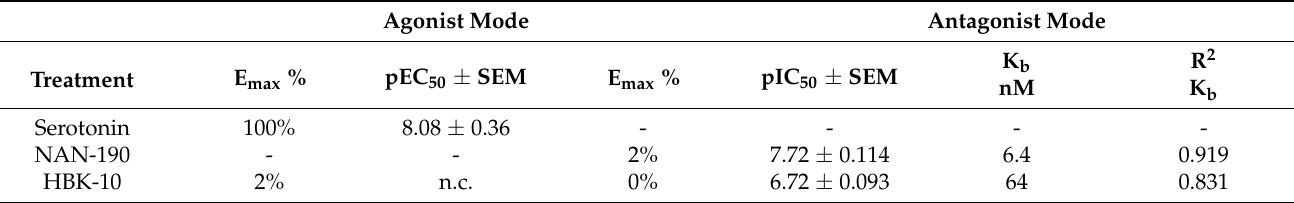
Table 5. Intrinsic activity of HBK-10 at the dopamine D 2 receptor.